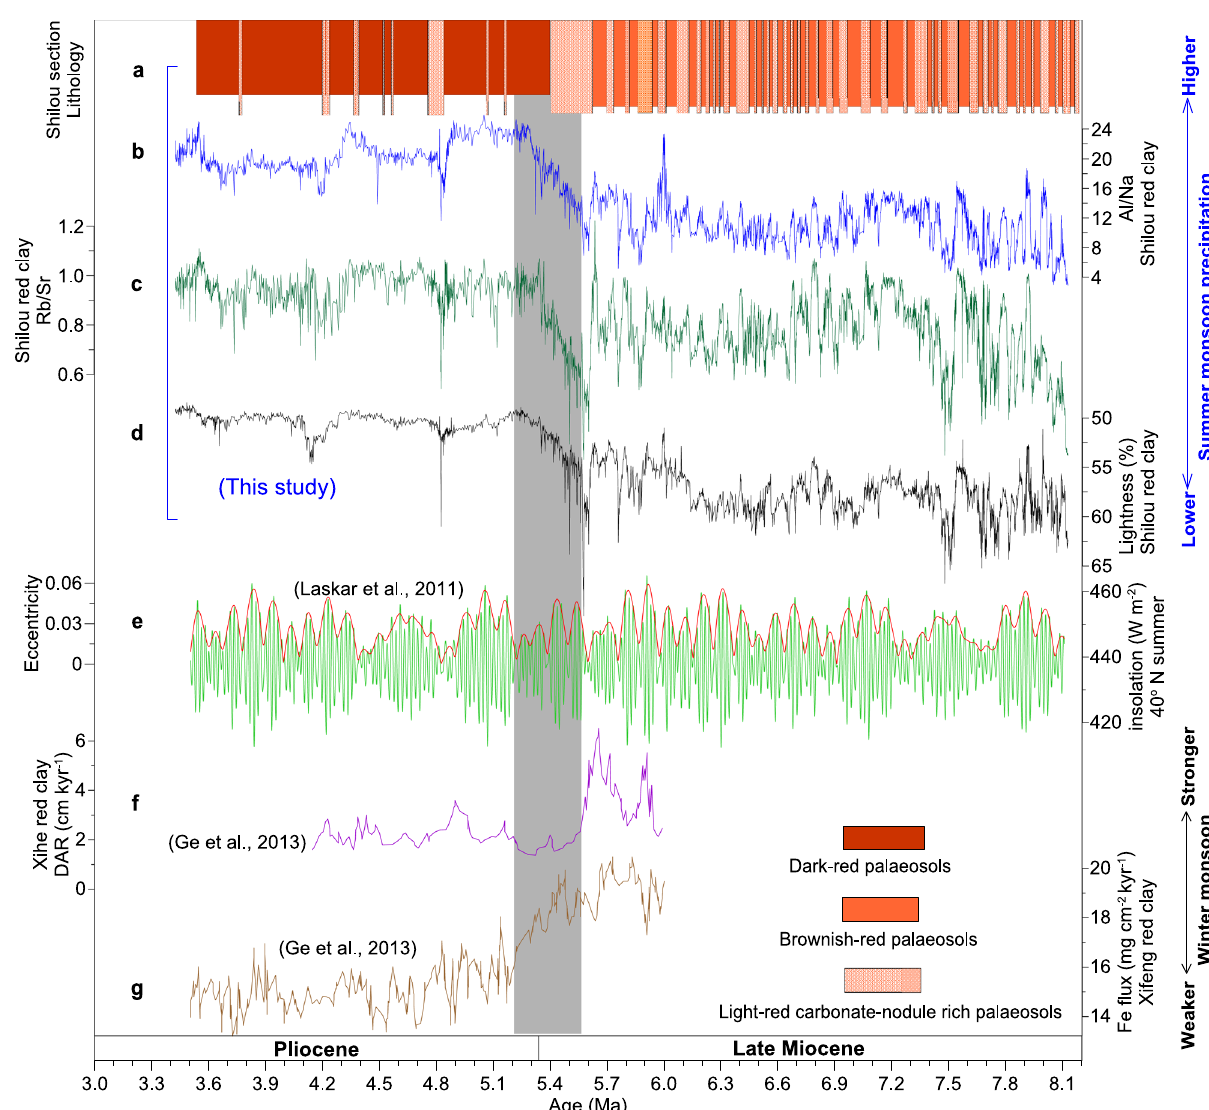
Fig. 2 Lithology and palaeoclimate proxy data for red clay from the Chinese Loess Plateau. a Lithology, b Al/Na, c Rb/Sr, and d lightness from the Shilou red clay sequence (this study). e 40° N summer insolation (green) and eccentricity (red) variations 31 . f Dust accumulation rates (DAR) for the Xihe red clay section 32 . g Fe fl ux for the Xifeng red clay section 32 . Summer and winter monsoon intensi fi ed and weakened, respectively, across the MPB